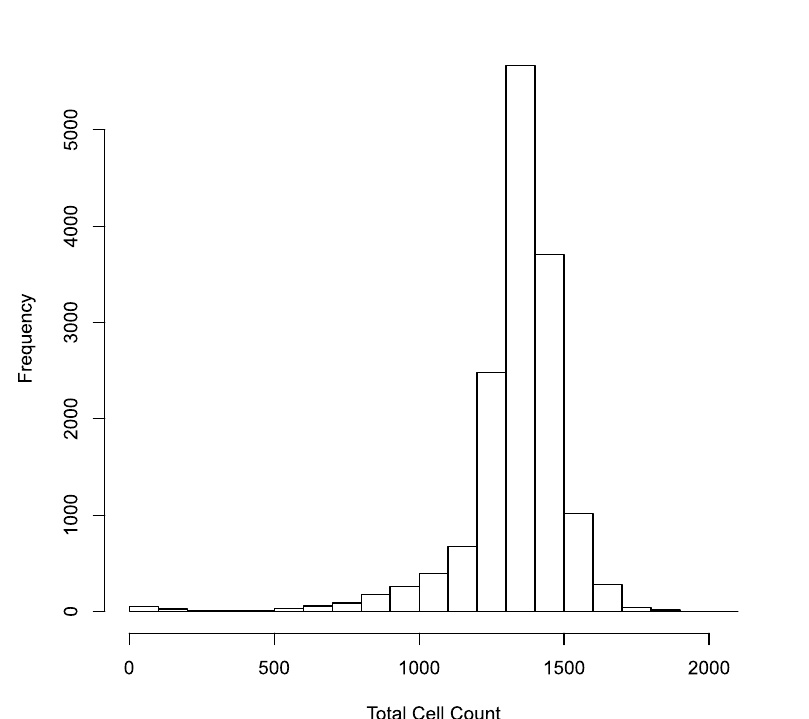
Fig 2. Total cell count distribution. Distribution of total cell counts across all samples, plate columns, fields, and